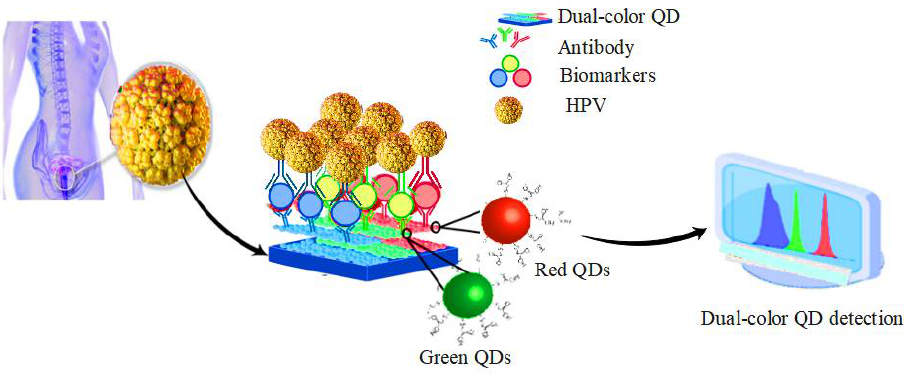
Figure 10. Detection of HPV infection by using dual-color QD detection method.